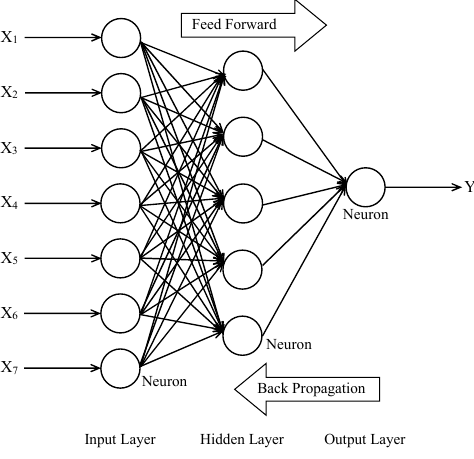
Figure 1. Architecture of a typical multilayer feed-forward neural network.